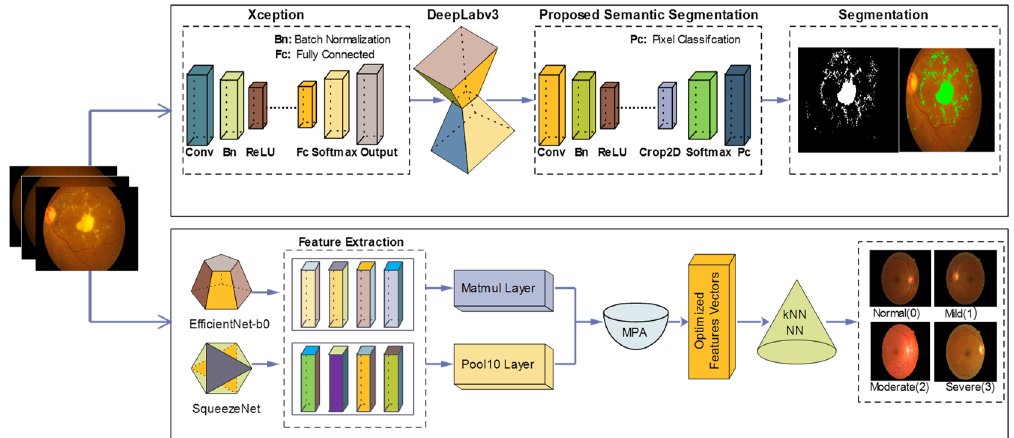
Figure 2. Steps of proposed method for segmentation and classification.